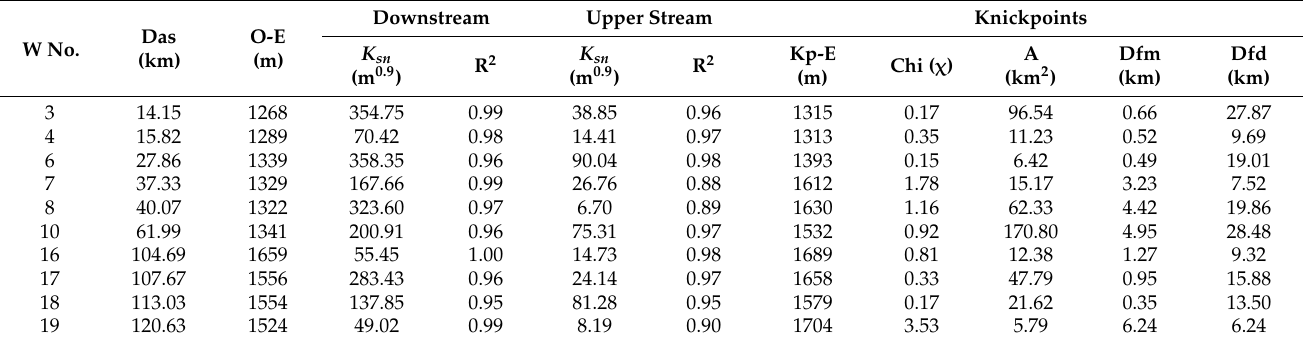
Figure 9. Longitudinal profile analysis of river channels. The selected watersheds were shown in Figure 4b. ( a – j ) represent streams. Watershed numbers are at the top right. Blue lines, red-dashed lines and red crosses indicate the original χ - z profiles, regressed χ - z profiles and the starts and ends of the fittings, respectively. Inverted triangles indicate abrupt changes of k sn between upper and down reaches, recognized as knickpoints. The red dot is the fault through the river channel, as shown in ( g ). Table 1. Results of river longitudinal